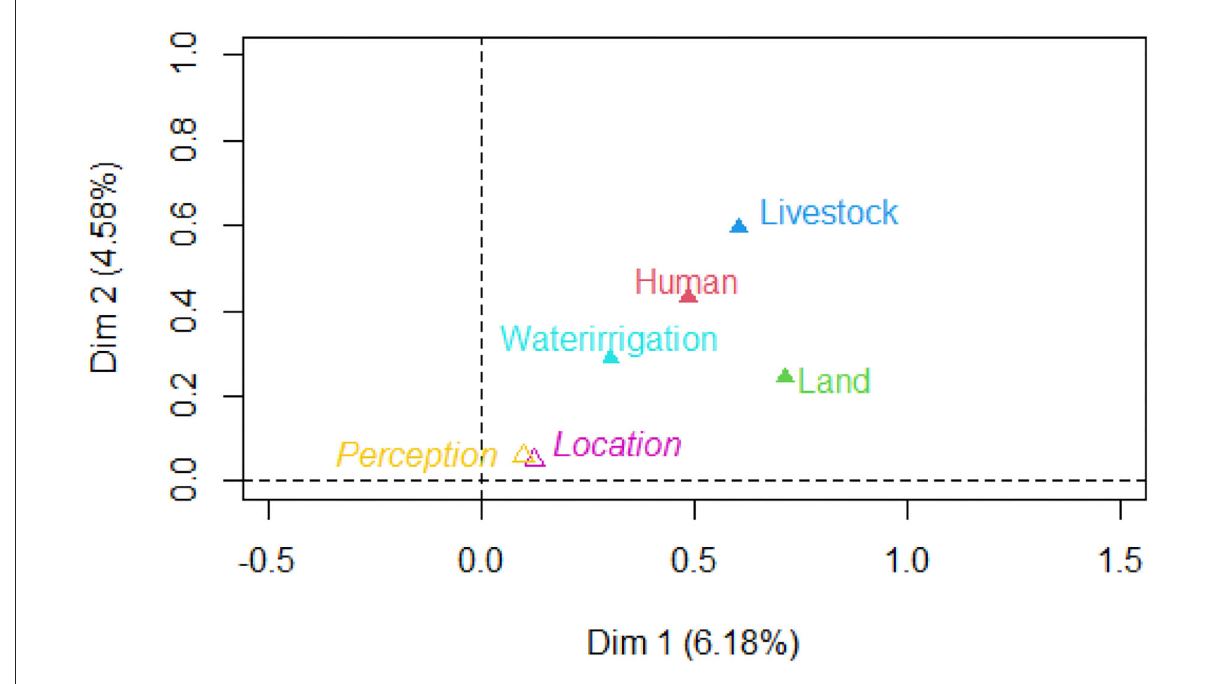
FIGURE3 Inter structure of different assets and themes for householders.